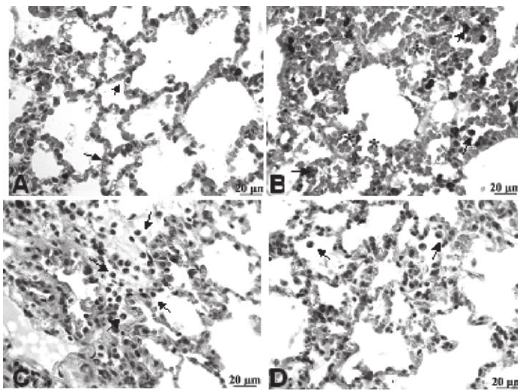
Figure 3 - Photomicrographs of HE-stained rat lungs using 400X magnification. (A) C-MV (control, mechanical ventilation) exhibits dilated and congested alveolar septa (arrows); (B) HCl group shows macrophages (arrow) and erythrocytes inside alveolus (asterisk); (C) HCl+PTX group exhibits some inflammatory infiltration, numerous macrophages, neutrophiles (arrows) and red blood cells; (D) PTX+HCl group, showing mild alveolar edema and few macrophages in the alveolar lumen